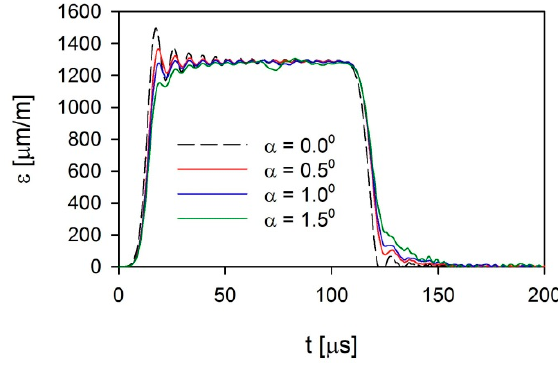
Figure 10. Incident-disturbed pulses for SHPB using a rounded striker for an imperfection in the form of inclination angle α between the striker and input bar.